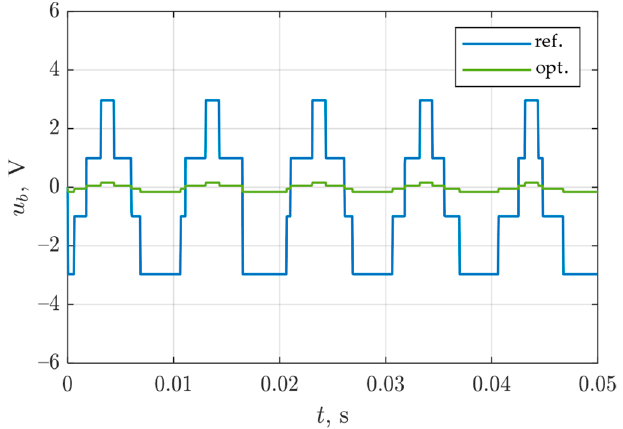
Figure 20. Comparison of bearing voltages for a reference and optimal solution.